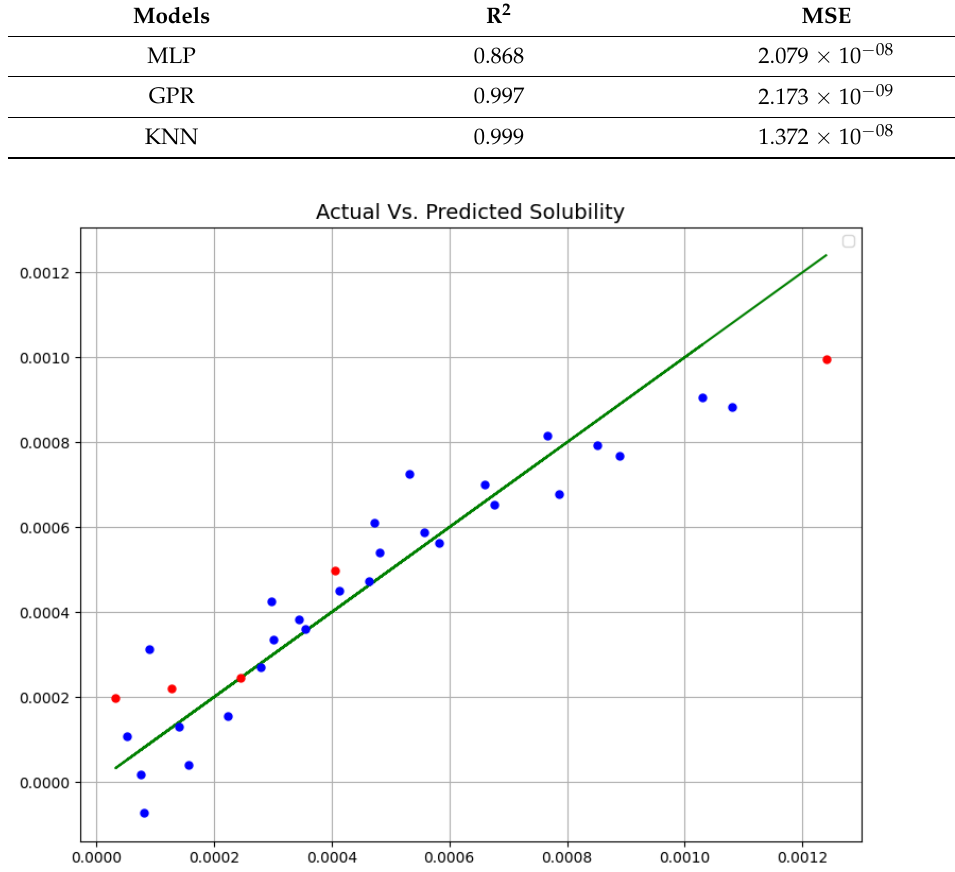
Table 2. Outputs based on R 2 and MSE. Models